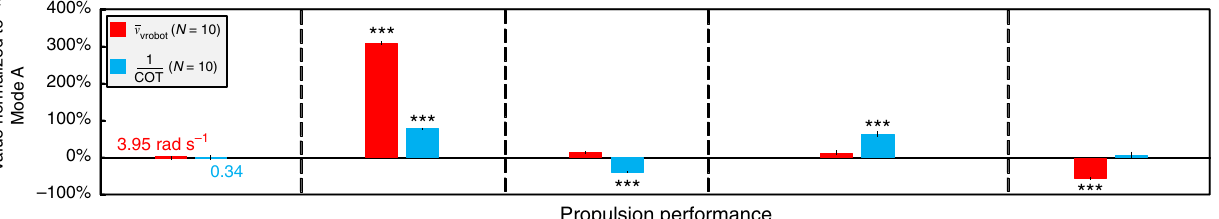
Fig. 2 Five basic swimming modes being investigated and their impacts on swimming propulsion. a Kinematics of each swimming mode. The video snapshots of the start and end frames in one cycle are shown in the fi rst row. One more frame is included for the glide phase of Mode B3. The red dashed lines indicate the fi nal position of the robot in Mode A. The overlapped body pro fi les in one cycle are shown in the second row. b The difference in kinematics veri fi ed by angular velocity change. The beating angles and the angular velocities are de fi ned in the inset. c The comparison in propulsion performance of each mode, showing the average velocity ( v ̅ robot , mm ⋅ s -1 ) and ef fi ciency represented by the reciprocal of cost of transport (1/COT). In b and c , the error bars represent the standard error of the mean, and N is the number of